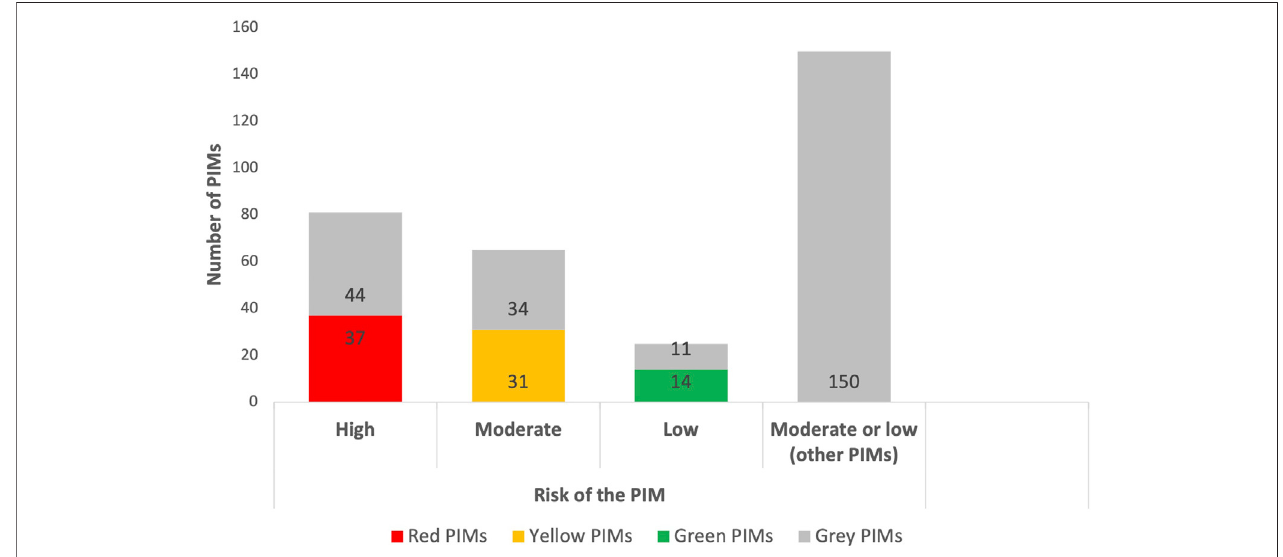
FIGURE 2 | Proportion of the high-, moderate- and low-risk PIMs in the integrated screening tool based on the EU(7)-PIM 1 and EURO-FORTA 2 criteria.